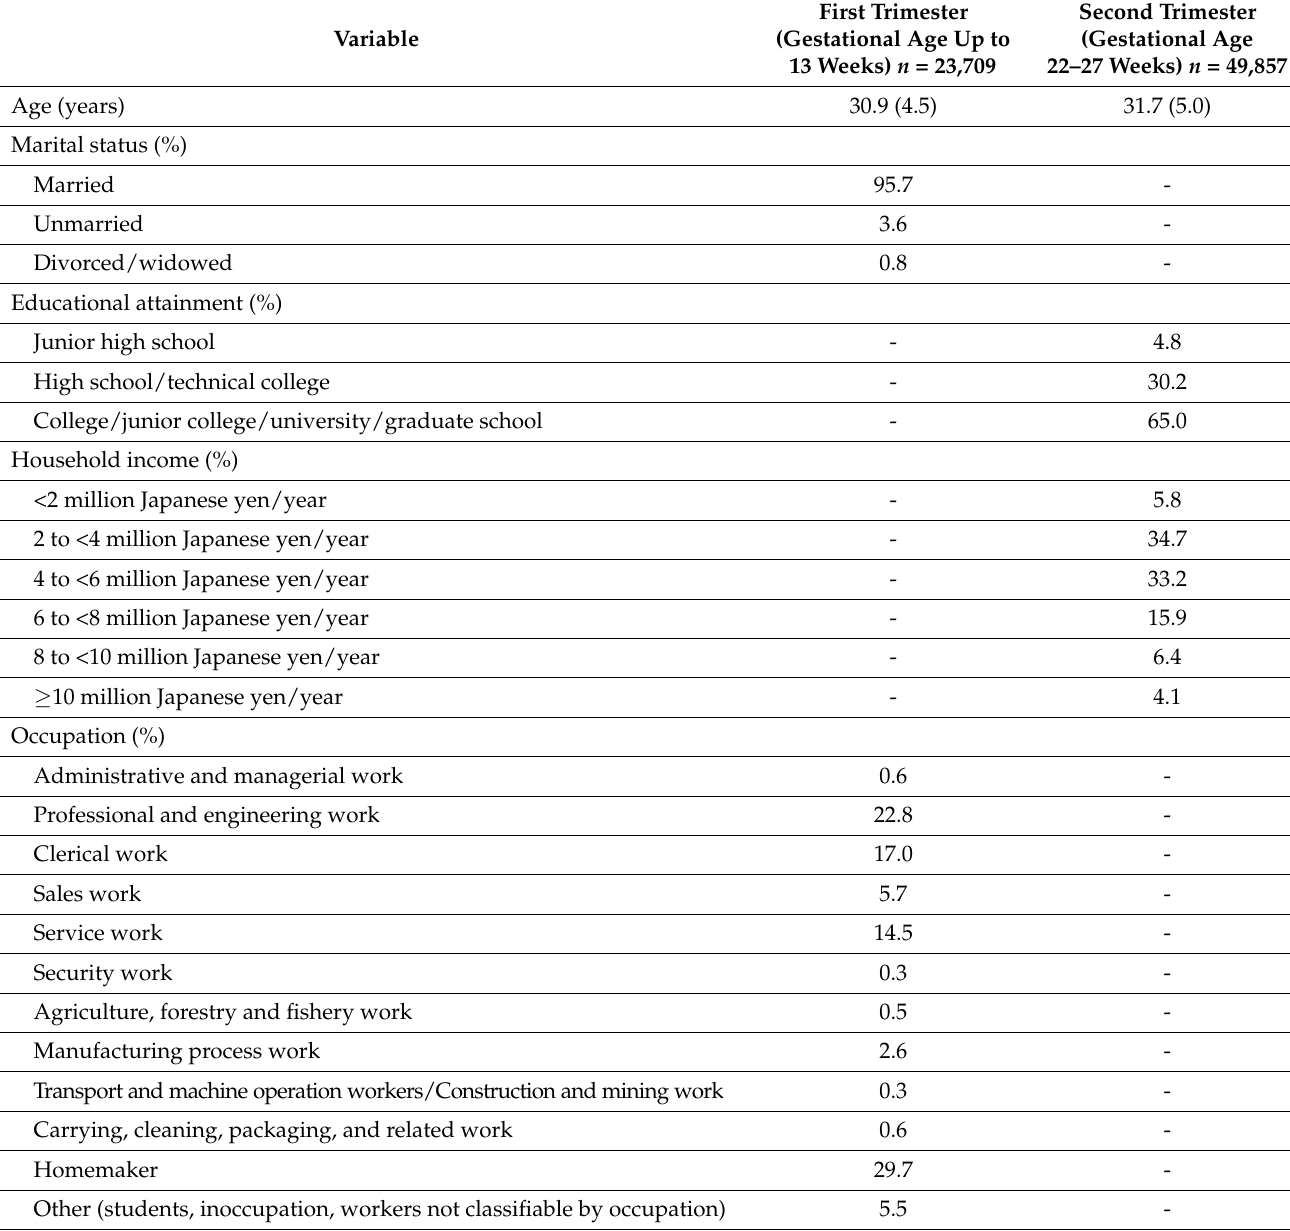
Table 1. Baseline demographic and health characteristics of pregnant women in their first and/or second